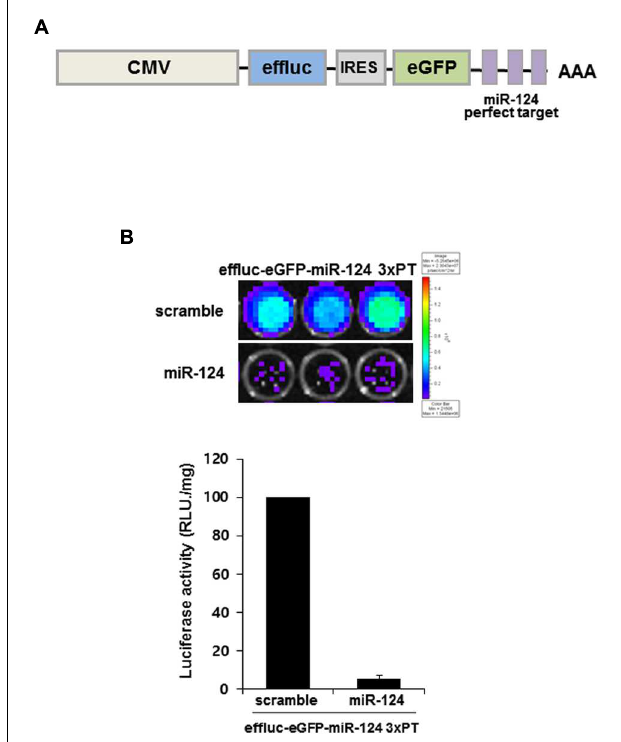
FIGURE 1 | MiR-124 action reporter vector and its validation. (A) Schematic diagram of miR-124 reporter transgene of lentiviral vector. The lentiviral construct consists of CMV promoter, effluc, IRES, and 3 × PT (triple perfect targets) including three repeat perfect target sequences complementary to mature miR-124. (B) Luminescence produced after 24 h of transient transfection of scramble or miR-124 showed working of effluc in the effluc-eGFP-miR-124_3 × PT transfected HeLa cells. Luciferase activity (photons/second) was quantified using Living image software. Data are represented by the means ± SEM ( n =